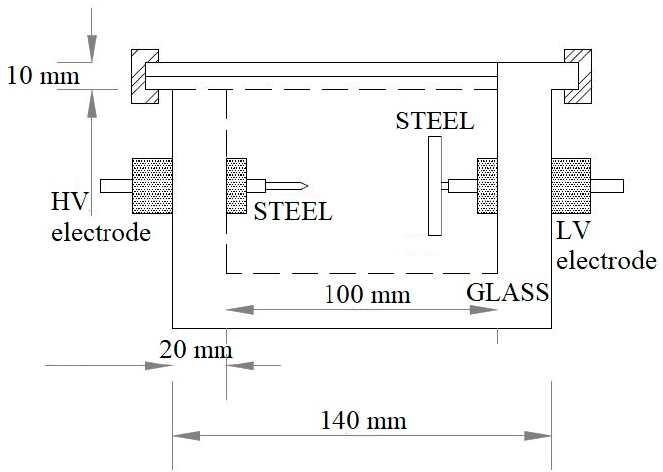
Figure 5. Self-designed transparent test oil container for testing oil samples in the lightning impulse